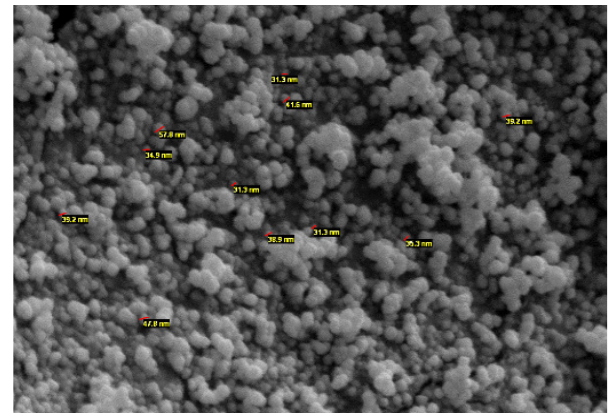
Fig.1. SEM image of